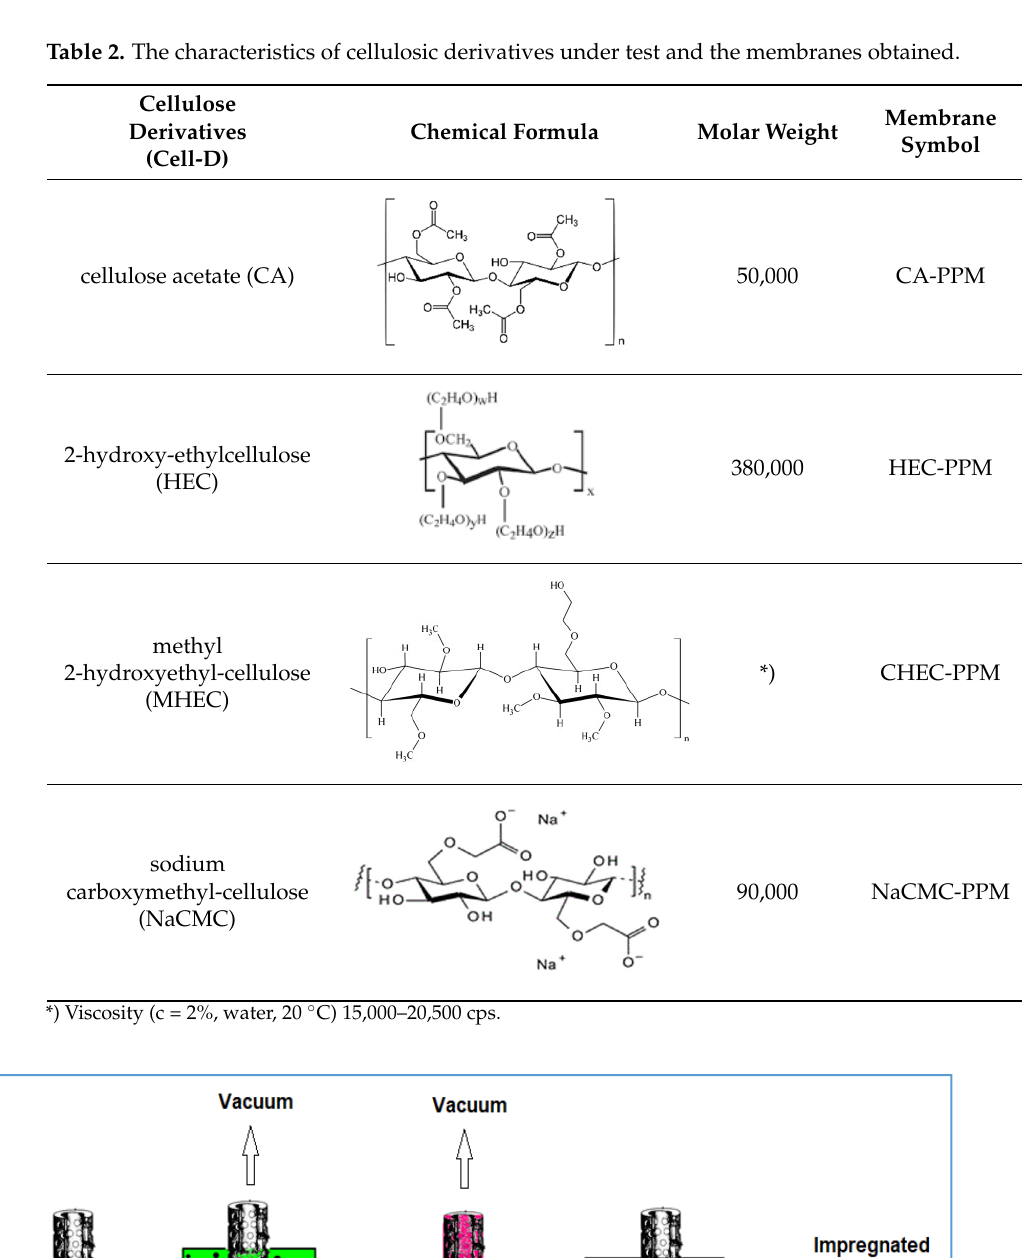
( b ) Figure 3. Schematic depiction of the impregnation procedure: ( a ) hollow polypropylene fiber bundles; and ( b ) scheme of the stages of the impregnation procedure. 2.3. Permeation Procedures In the source phase (SP) the synthetic solution of the considered chemical species (amino acids—Table 3), with a concentration of 0.150–0.250 mol/L, is introduced in the installation (Figure 4). The pH of the source phase is made with hydrochloric acid solution 0.01 mol/L, deionized water, or sodium hydroxide 0.1 mol/L. The receiving phase (RP) is formed in all cases from deionized water. The volume of the source phase is 10 L, and of the receiving phase is 1 L. The operating flows are the same for all experiments, for oper-